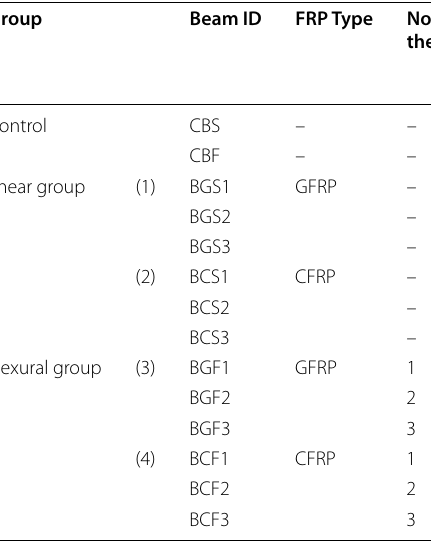
are given in Table 3. Characteristic compressive cube strength, f cu , of the LWC mix was 32 N/mm 2 is the aver- age strength obtained by testing six cube specimens of 150 150 150 mm. Six cylindrical Specimens of 150 × × diameter 300 mm height, were tested under compres- × sion to obtain the stress–strain response. The average cylindrical compressive strength was f The average density of LWC was 1740 kg/m 3 .